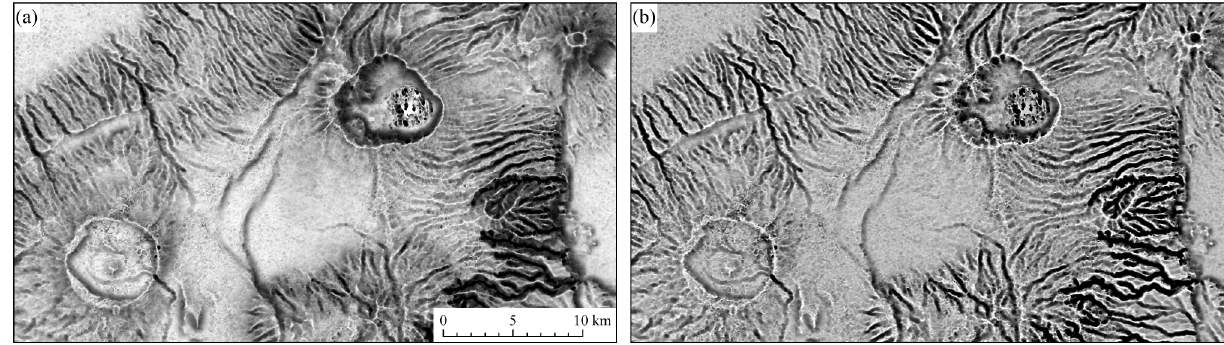
Figure 3. An example of the SVF based visualization for the volcanic region in Tanzania. Olmoti (below left), Embagai (in the middle) and small Kerimasi craters (above right) are visible. We tested visualizations based on a celestial hemisphere (a) and a celestial sphere ( b) . When considering the whole sphere, the results have an increased range (SVF can theoretically reach a value of 2). This brings improvement in automatic detection of linear structures because the method exposes many edges. The results however, are not intuitive because slopes are visualized in the same manner as a horizontal plane. Therefore, it is difficult to distinguish between